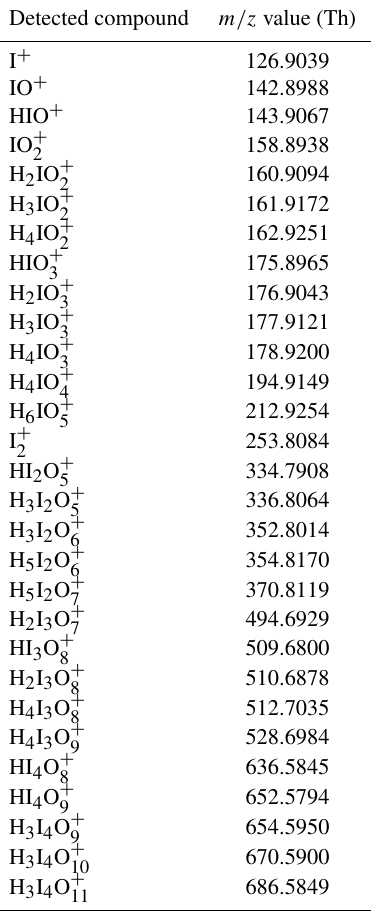
Table 2. Iodine-containing compounds (atomic composition), to- gether with their m/z values, identified in the water cluster CI-APi- TOF spectra during the CLOUD13